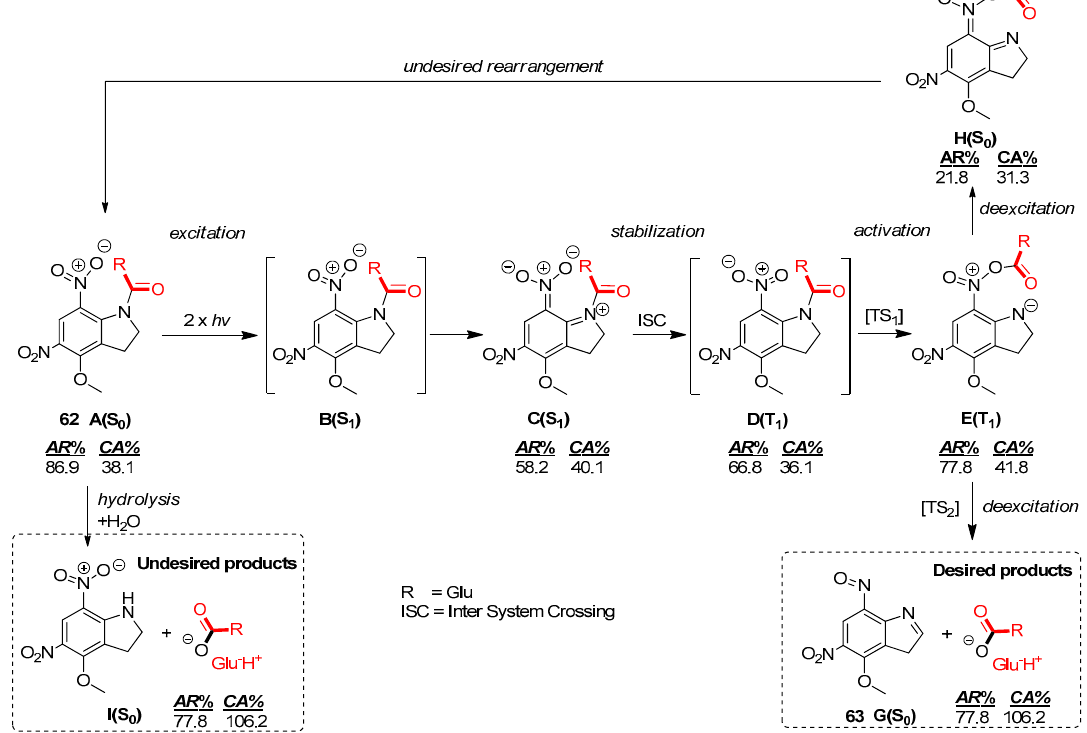
Figure 24. Quantum chemical modelling of the photochemical reactions as well as the simplified mechanisms of ground state hydrolysis for DNI-Glu ( 62 ). The aromaticity (AR%) of the benzene ring and carbonylicity of the carbonyl functionality along the mechanism are computed at B3LYP/6-31G(d,p)//PCM(water) level of theory [37].